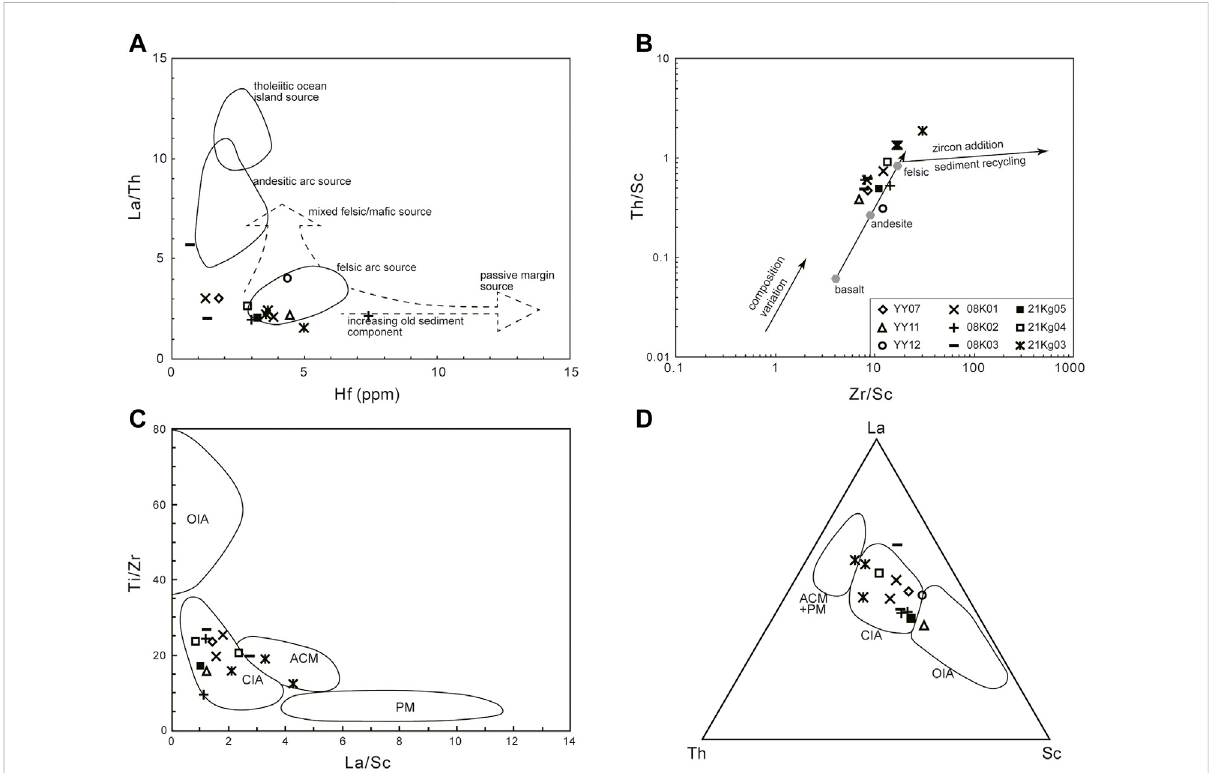
FIGURE 11 Tectonic setting discrimination diagrams for the sandstone matrix in the KGSC in the HL area. (A) Hf vs. La/Th diagram (Floyd and Leveridge, 1987), (B) Th/Scvs.Zr/Scdiagram(McLennanetal.,1993), (C) La/Scvs.Ti/Zr, (B) Th-Co-Zr/10and (D) La – Th – Scplots(BhatiaandCrook,1986).ACM, active continental margin; PM, passive continental margin; CIA, continental island arc; and OIA, oceanic island